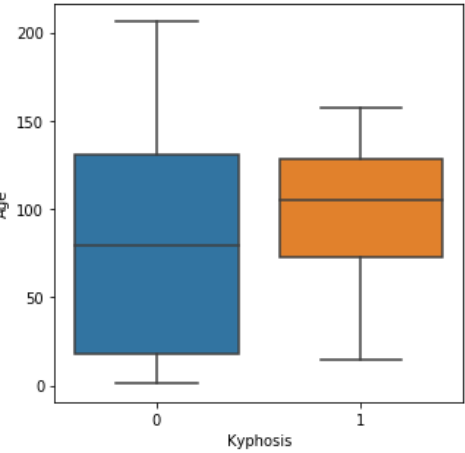
Figure 12. ( a ) The correlations between the features in the data; ( b ) The patterns of the kyphosis identified among the three input features (Age, Start, Number).